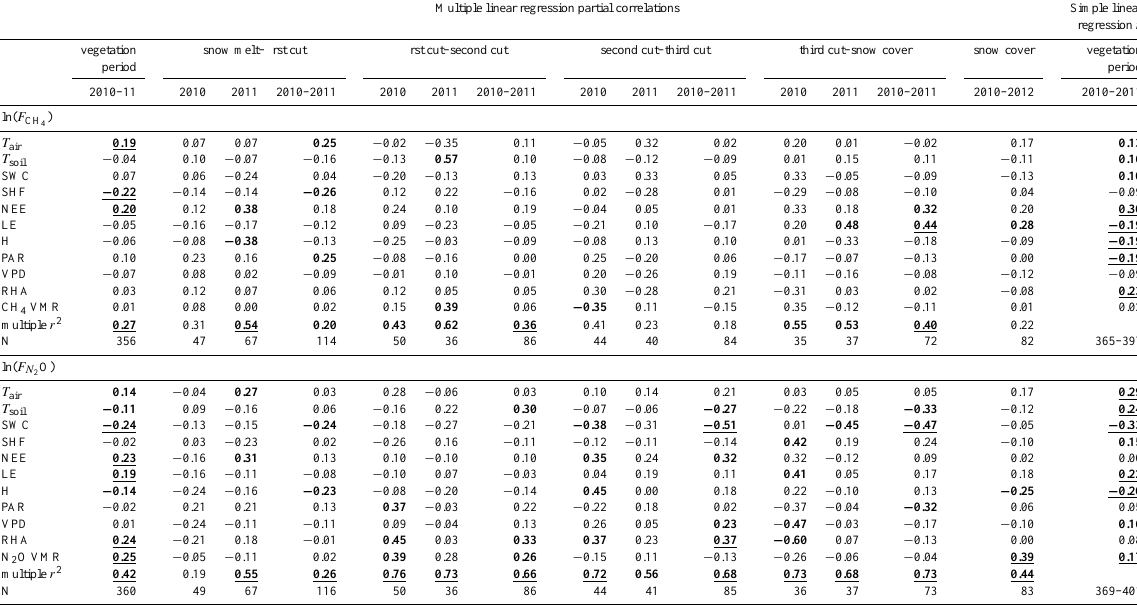
Table 1. Partial correlations of a multiple linear regression analysis and correlation coefficients ( r ) of a simple linear regression analysis ) and N 2 O ( F N ) flux rates as dependent variables and air temperature ( T air ) , soil using daily average values of ln transformed CH 4 ( F CH 4 2 O temperature ( T soil ) and soil water content (SWC) at 5cm depth, soil heat flux (SHF), net ecosystem CO 2 exchange (NEE), latent heat flux (LE) and sensible heat flux (H), photosynthetically active radiation (PAR), vapor pressure deficit (VPD), relative air humidity (RHA) and CH 4 (N 2 O) volume mixing ratios (VMRs) as independent variables. Management events were excluded from the analysis. Bold numbers highlight p <0.05, except bold underlined numbers resulted in p <0.001. Results shown for the vegetation period do not include time periods with snow cover on the meadow.